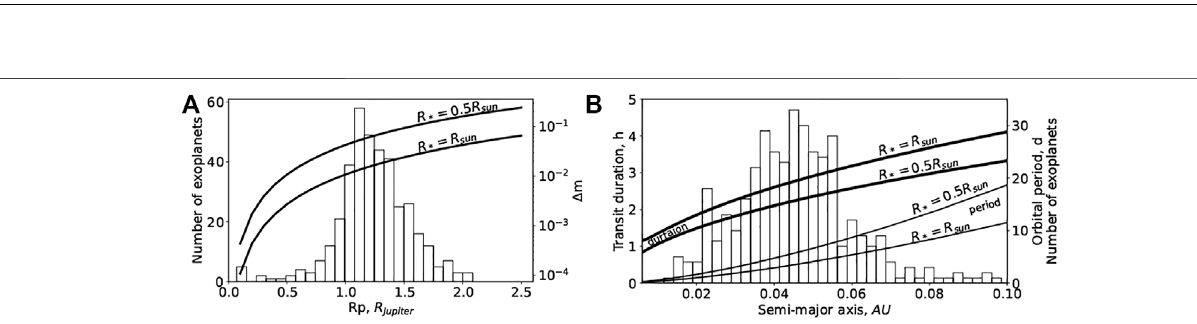
TABLE 1 | Objects of interest and transit event parameters. Object